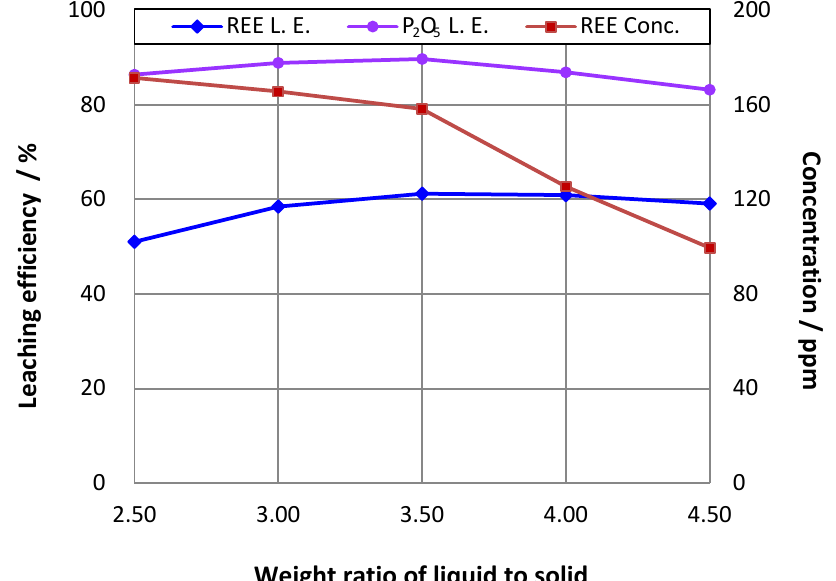
Figure 4. Effect of ratio of liquid to solid on rare earth leaching efficiency (L.E.) (16% P 2 O 5 in the initial leaching pulp; leaching temperature = 75 °C; stoichiometric ratio of H 2 SO 4 to CaO = 1.1).